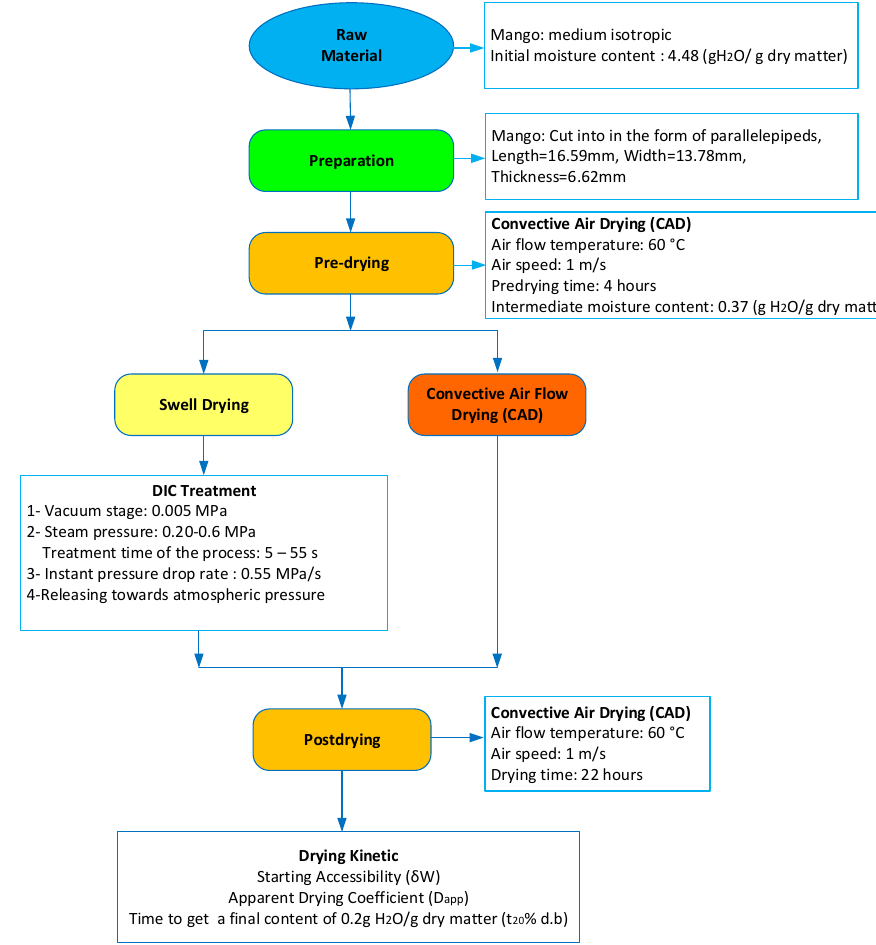
Figure 1. Drying protocol of